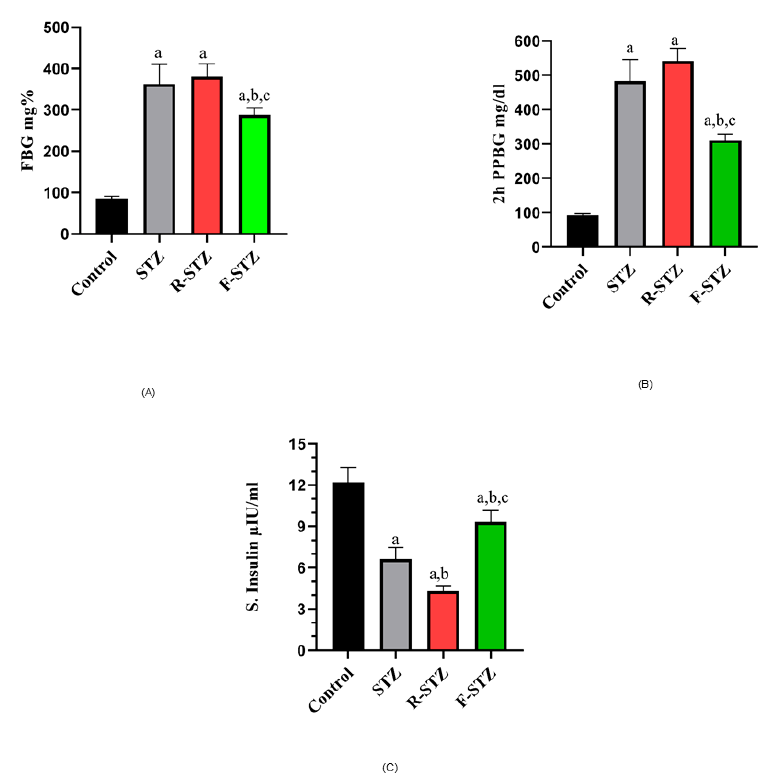
Figure 1. Blood glucose estimation in different experimental groups ( A ) FBG (mg/dl); ( B ) 2 h postprandial blood glucose (mg/dl); ( C ) Fasting serum insulin level ( µ IU/ml) in the different studied groups. (a) Significant difference from normal control group at p < 0.05; (b) Significant difference from STZ group at p < 0.05; (c) Significant difference from R-STZ group at p < 0.05. Table 1. Lipid profile of normal control and diabetic rats of STZ-treated groups (R-STZ and F-STZ) Table 2. Kidney and liver function tests of normal control and diabetic rats of STZ-treated groups (R-STZ and F-STZ). Serum Parameters (mg/dl)\ Group (n) Parameters \ Group